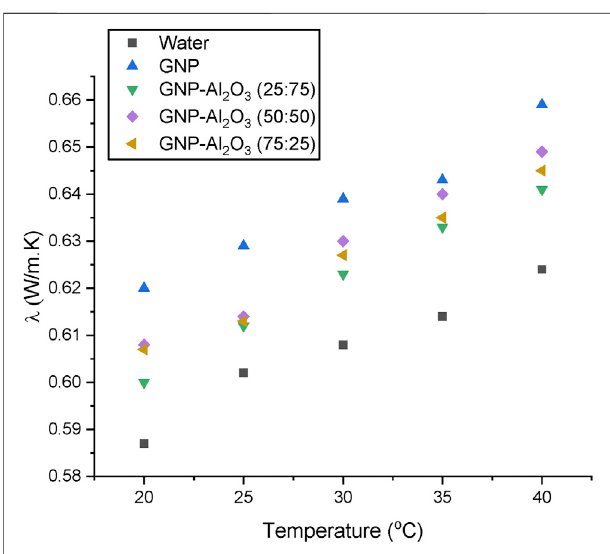
FIGURE 7 | Thermal conductivity of the GNP-alumina hybrid nano fl uids for different mixing ratios as a temperature